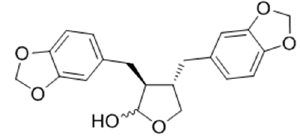
Figure 34. Structure of ( − )-cubebin.